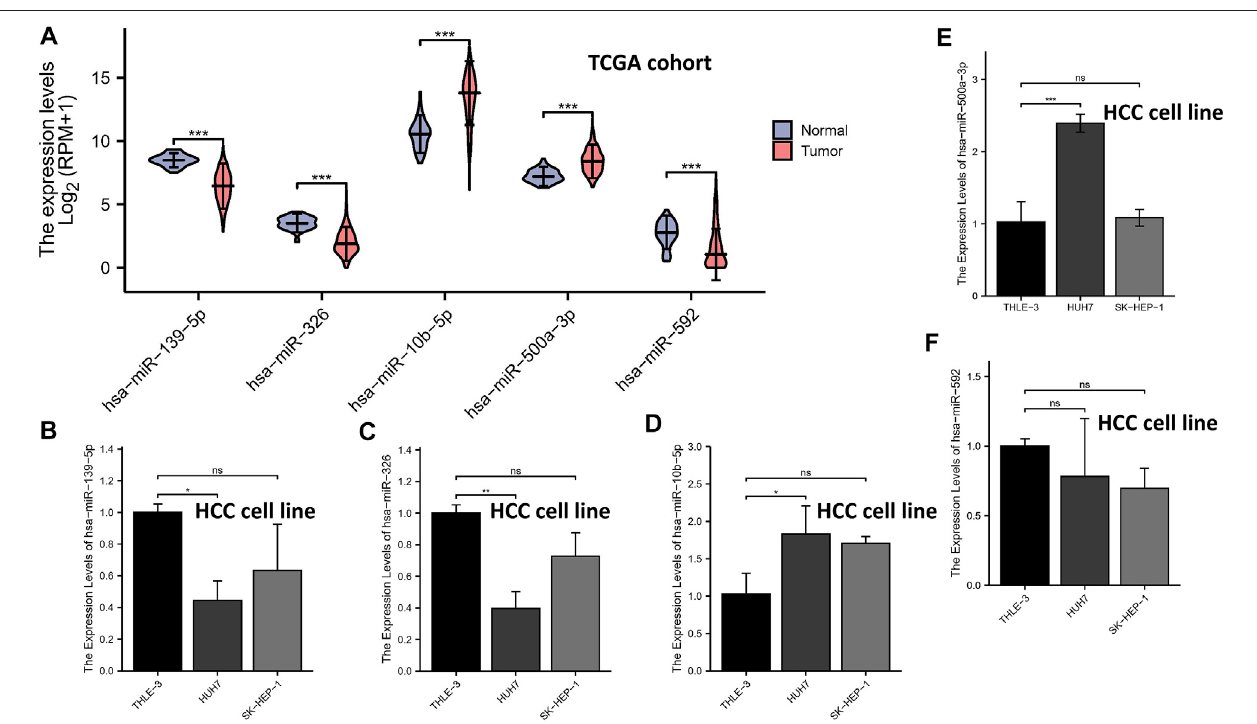
FIGURE7| qRT-PCR. Theexpression levels ofthe5-miRNAs inthe TCGA database (A) . Theexpression levels ofmiR-139-5p (B) ,hsa-miR-326 (C) , miR-10b-5p (D) , miR-500a-3p (E) , and miR-592 (F) .